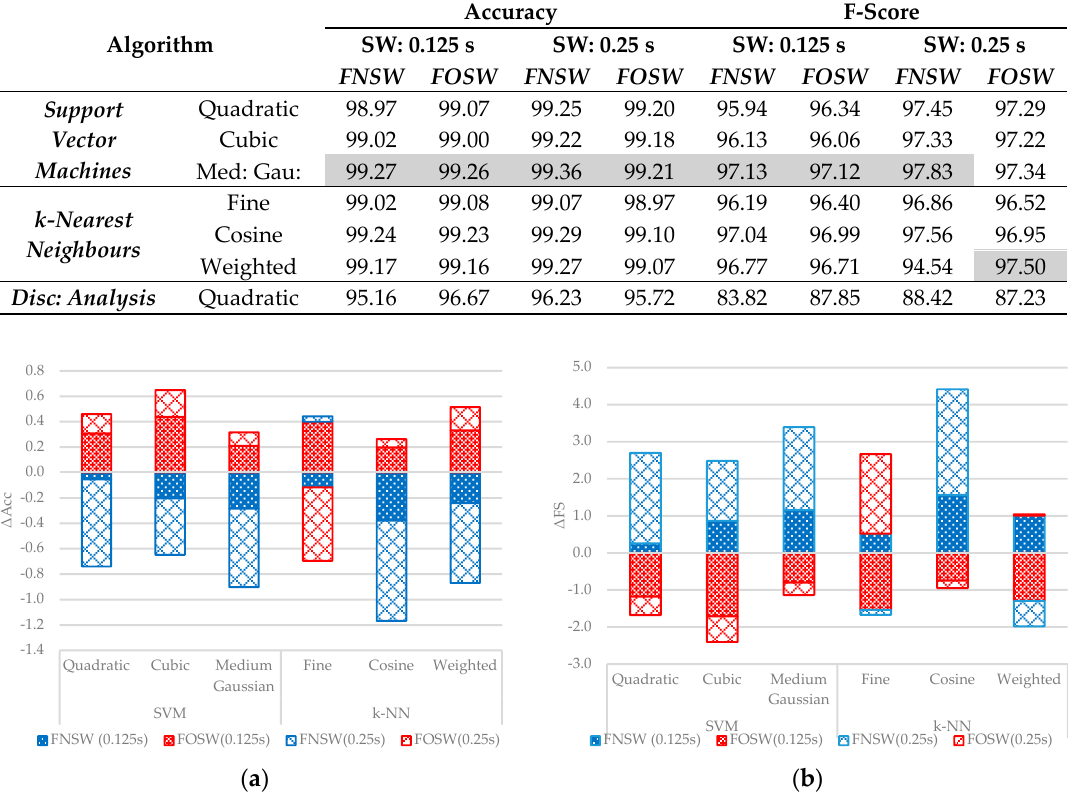
Table 2. Accuracy and F-score performance of the classifiers when applied on the unseen test data set.